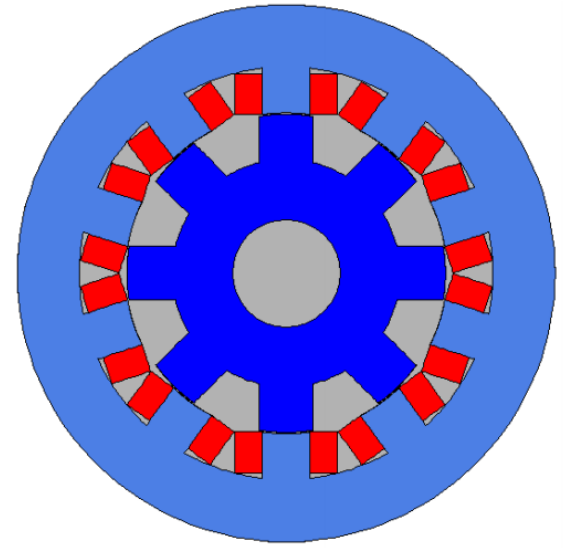
Table 6. Parameters used for model procurement of a 10/8 motor.